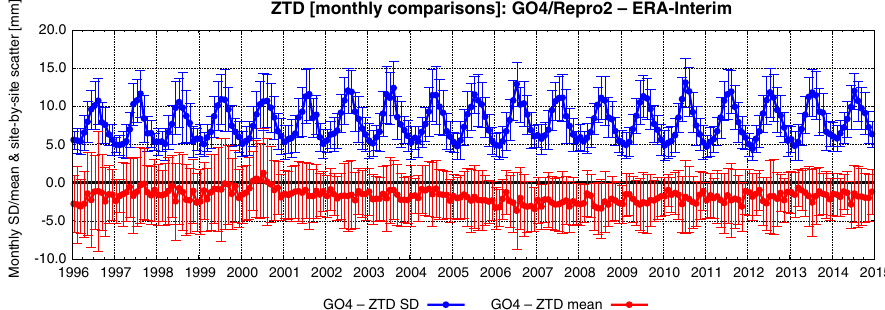
Figure 8. Monthly means of bias and standard deviation of the official GOP ZTD products compared to those of the ERA-Interim. Error bars indicate standard errors of mean values over all compared stations.